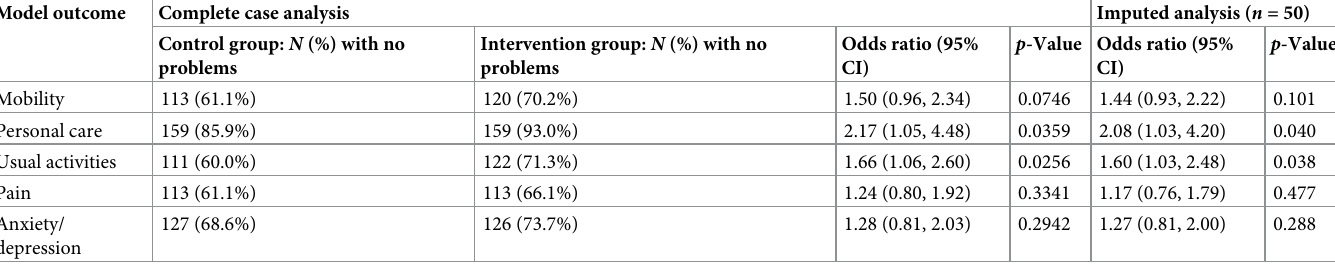
Table 5. Logistic regression results for dichotomised (no problems versus some problems) EQ-5D sub-items. Model outcome